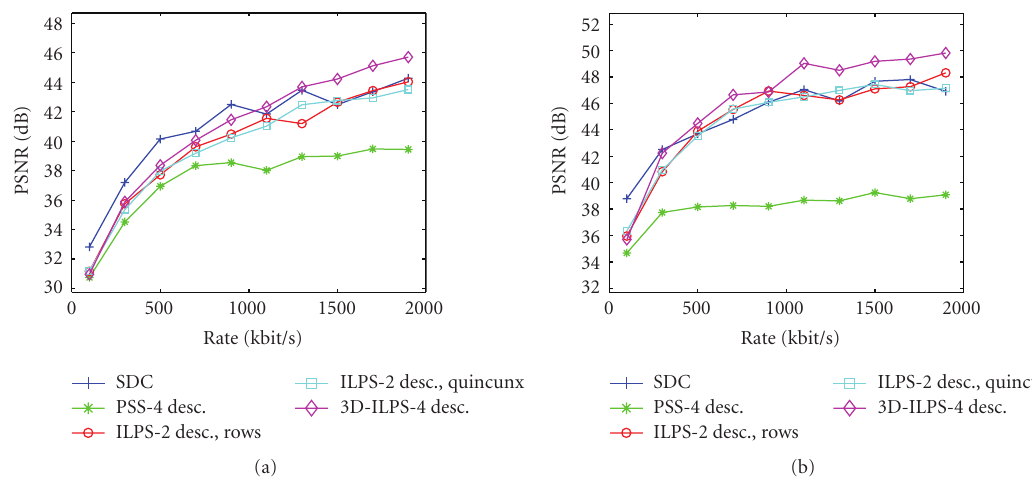
Figure 18: Performance of color view, all subsequences received, 10% packet loss. (a) Breakdance. (b) Ballet.